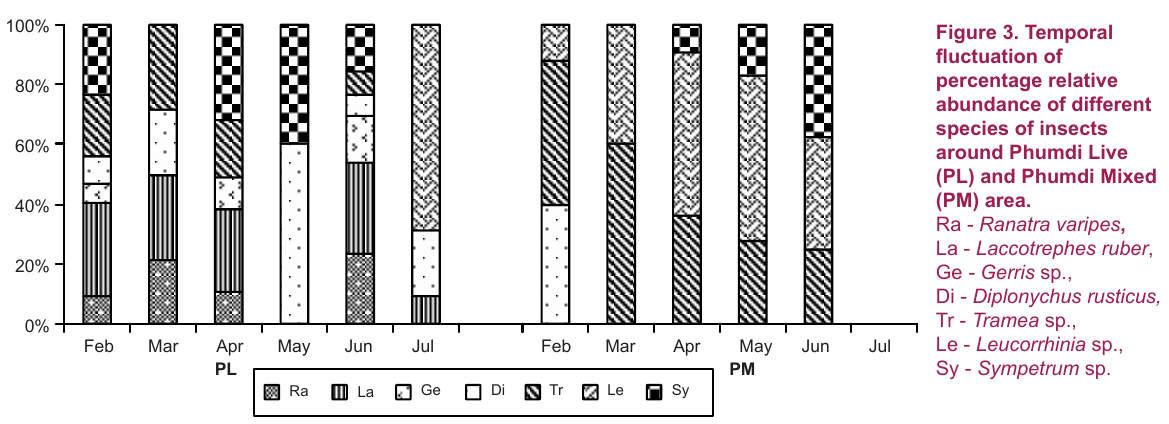
representation of the family Nepidae in the PL area could be due to the fact that they usually inhabit lentic to hold as they lie in wait for capturing prey (Usinger 1968; McCafferty 1981). The percentage of relative abundance of different species in the two habitats clearly indicated the preference of Hemipteran insects for PL. Although odonates did not show any differences in the community composition between the relative abundance of different species were recorded.